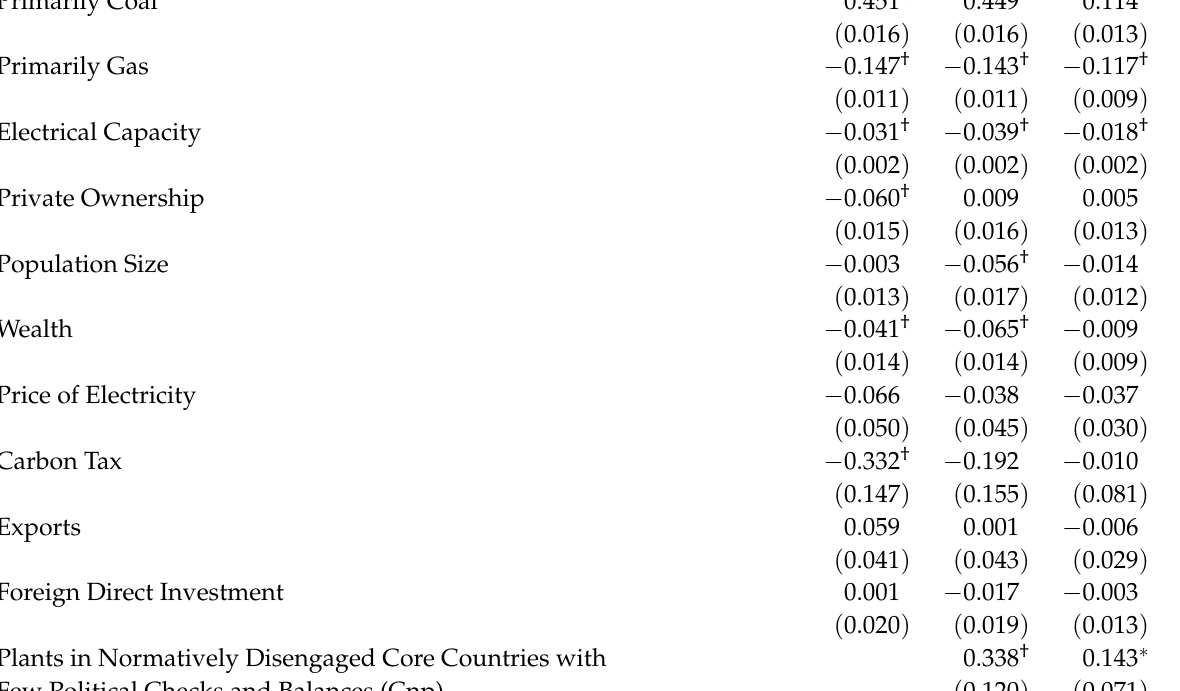
2 emission rates